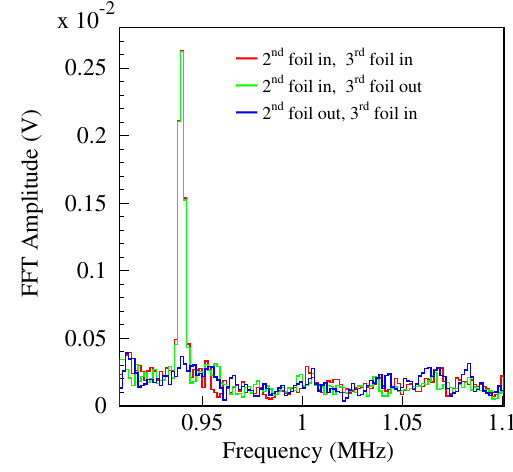
FIG. 8. Individual measurement of the H 0 and H (cid:1) component of the waste beam. FFT spectra for measuring separately the H (cid:1) one, the H 0 one, and as a whole ( H (cid:1) and H 0 ) of the waste beam are shown by the blue, the green, and the red colors, respectively. Almost no difference in between the red and green colored spectra and no clear signal in the spectrum with light-blue color proves that the waste beam is mainly the partially stripped H 0 one, where the unstripped H (cid:1) component of the beam is negli- gibly small.